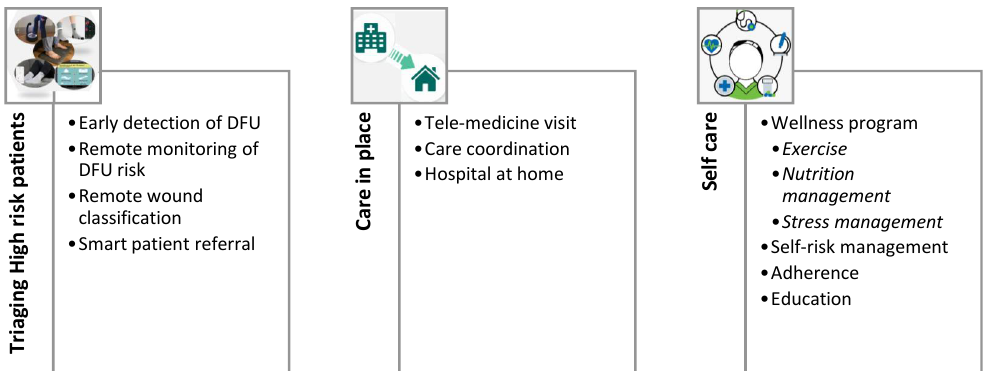
Figure 1. Recent developments in three specific areas are discussed (shown in detail in Figure 1): (1) Triaging high-risk patients for timely intervention, (2) Care in place to avoid frequent hospital visits, and (3) Self-care to empower patients and their caregivers. DFU: diabetic foot ulcer.